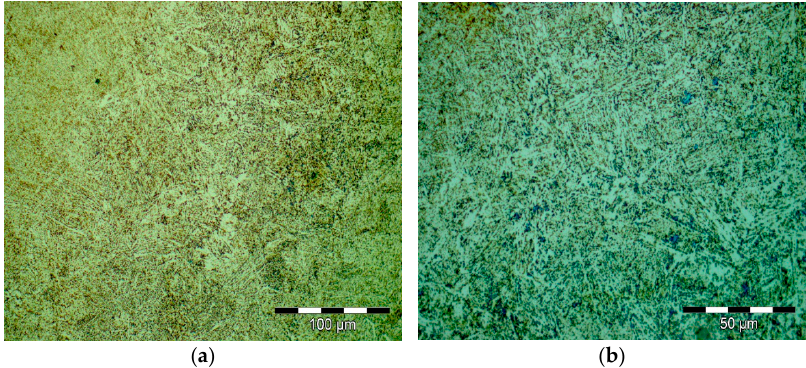
Figure 8. Optical microscopy images from secondary heat treatment; 500× magnification ( a ) 1000× ( b ).